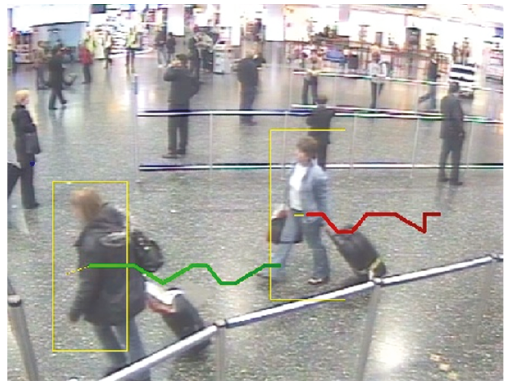
Figure 12: Samples of human region trajectories.